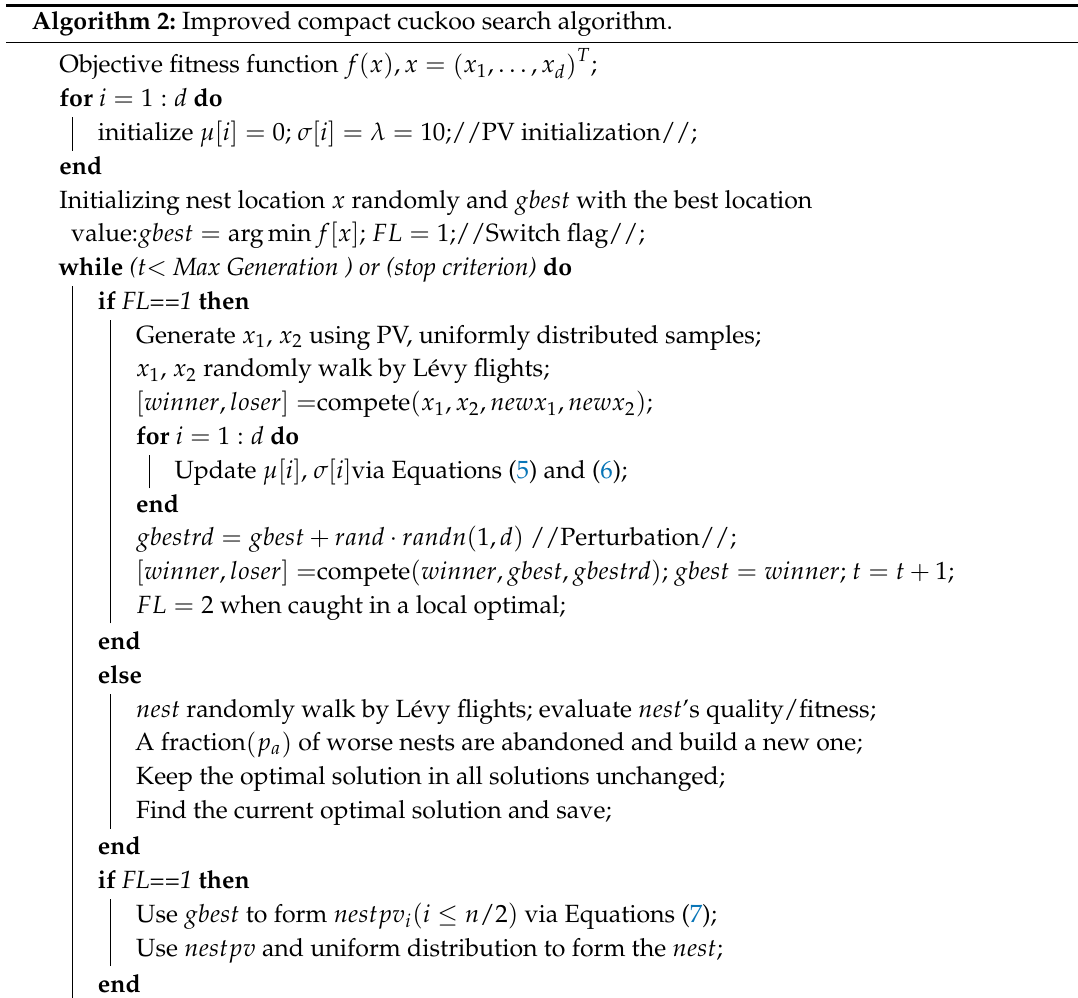
Algorithm 2: Improved compact cuckoo search